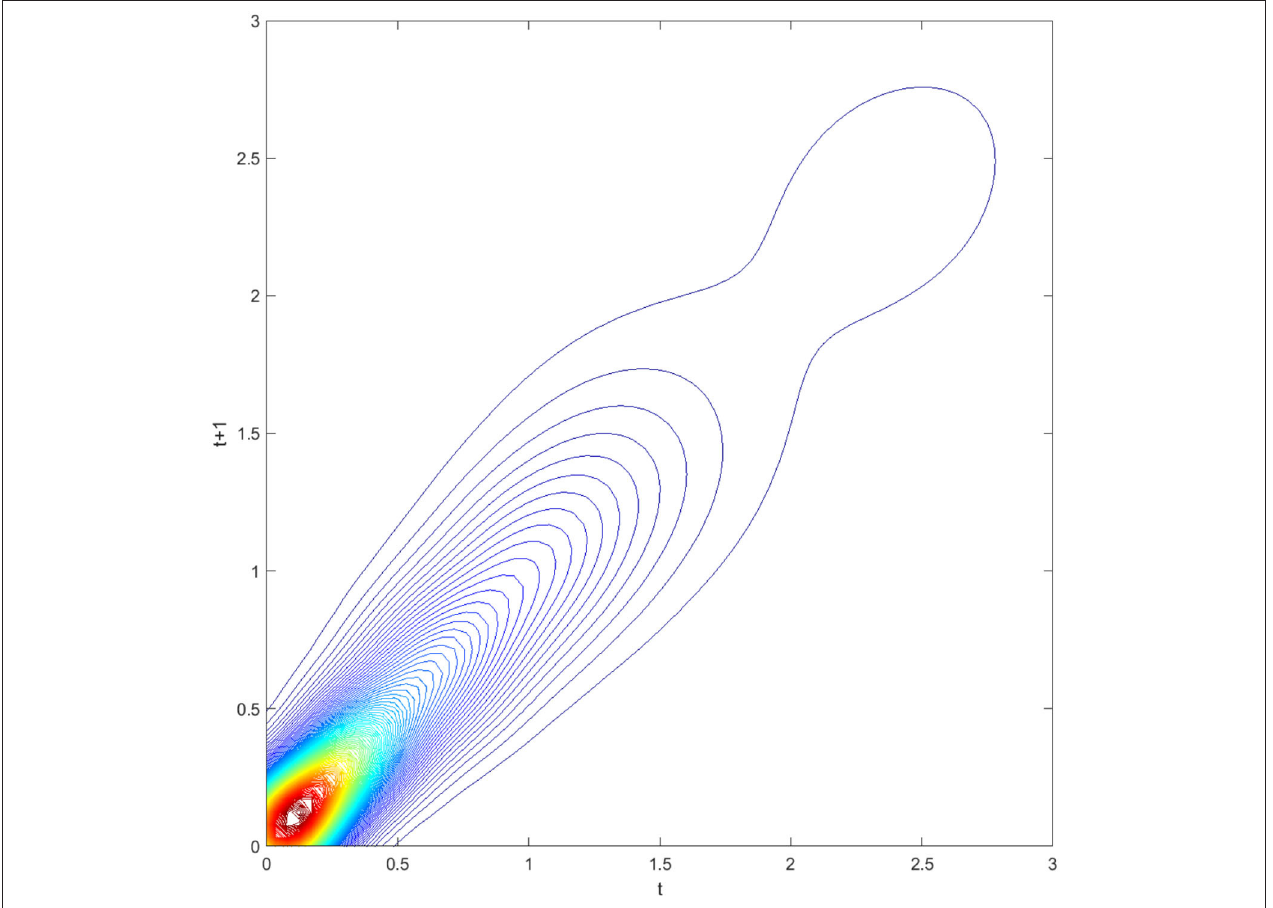
FIGURE 2 | Contour map of transition probability kernel for the RIVAPC of all countries with annual transitions. Source: authors’